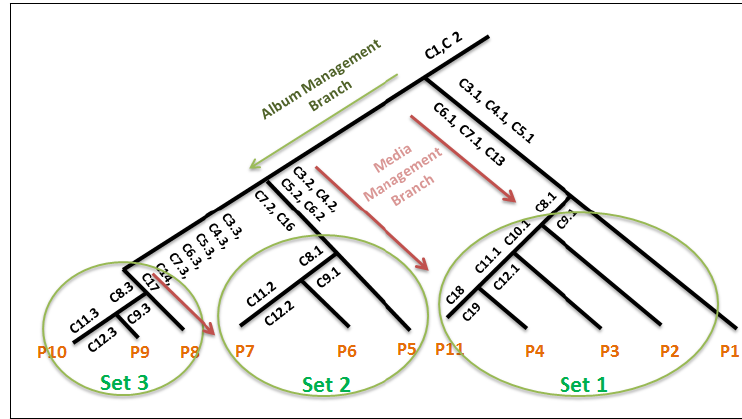
Figure 2. Cladogram